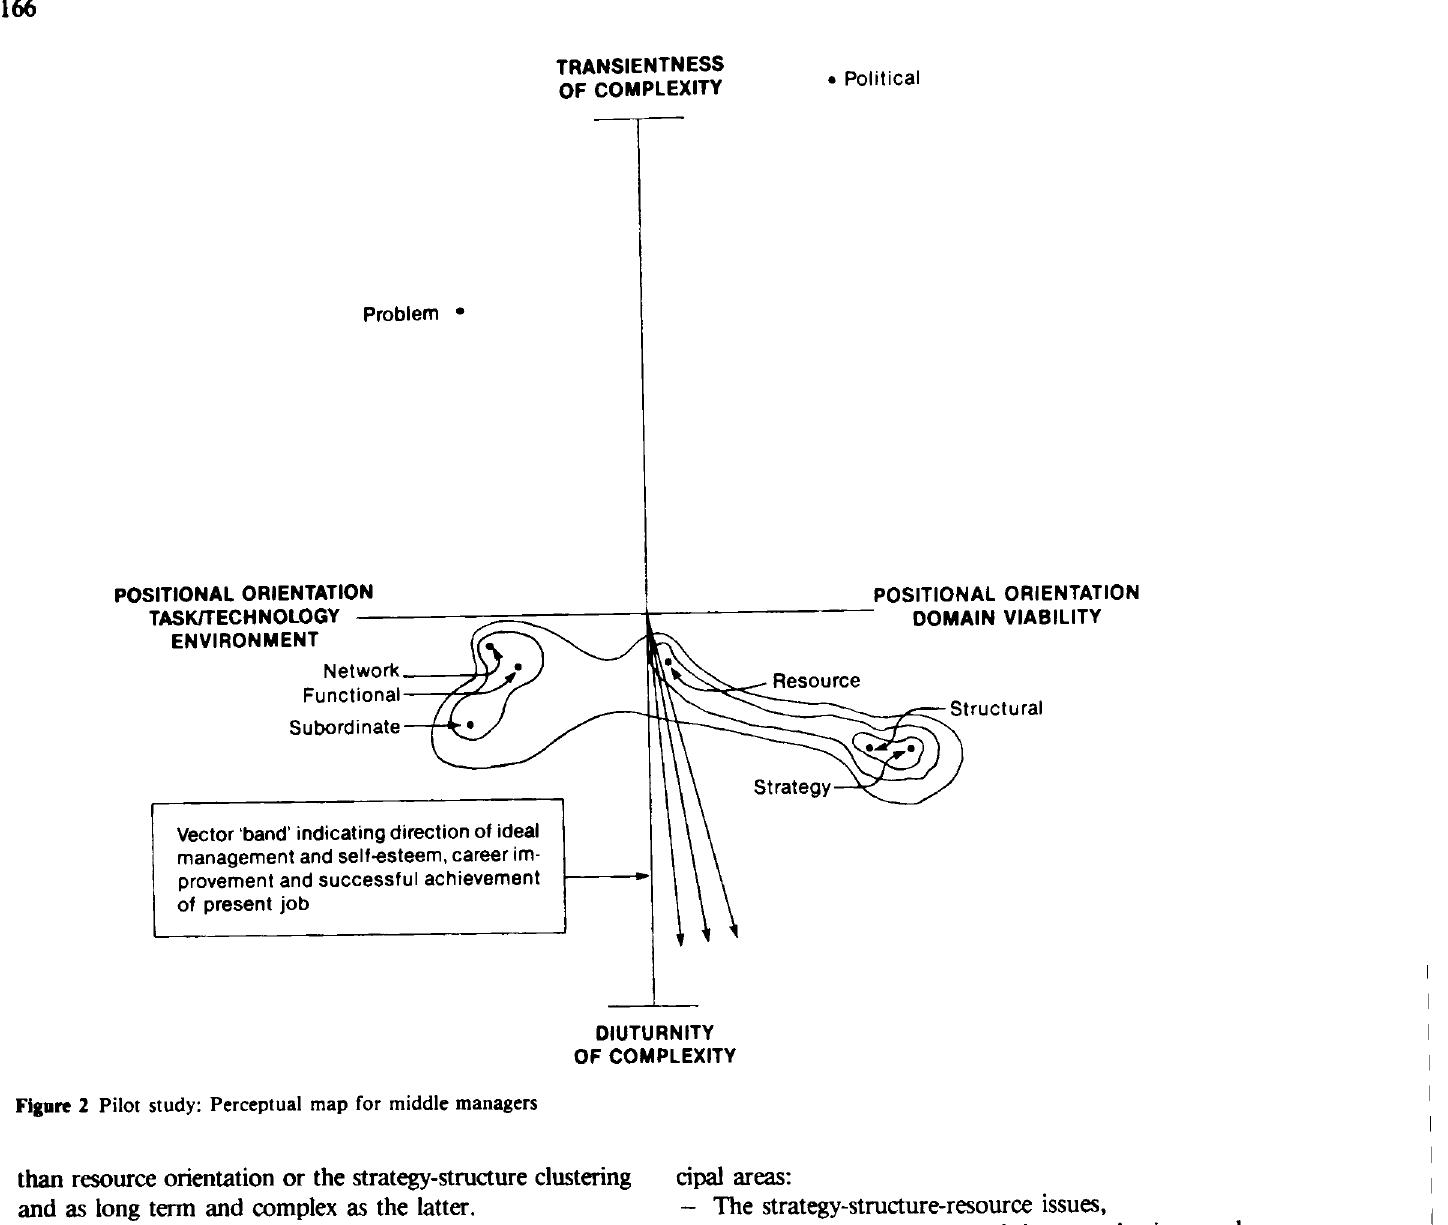
Flpre 2 Pilot study: Perceptual map for middle